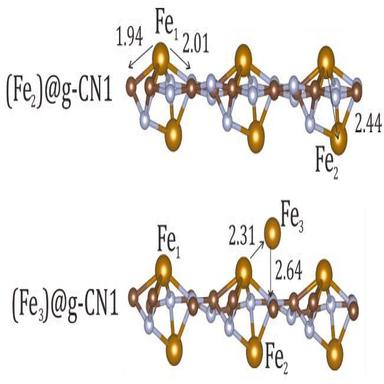
Atomic structure of g-CN1-Fen (n = 2,3) unit cells. Nitrogen atoms are depicted in grey, carbon atoms depicted in brown, iron atoms are in golden. Bonds (in Å) are indicated with arrows.